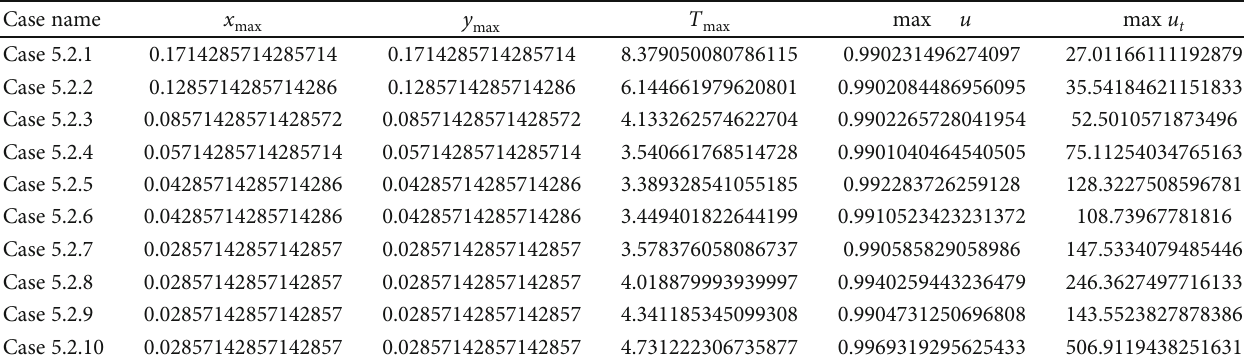
b x and y based on convection term